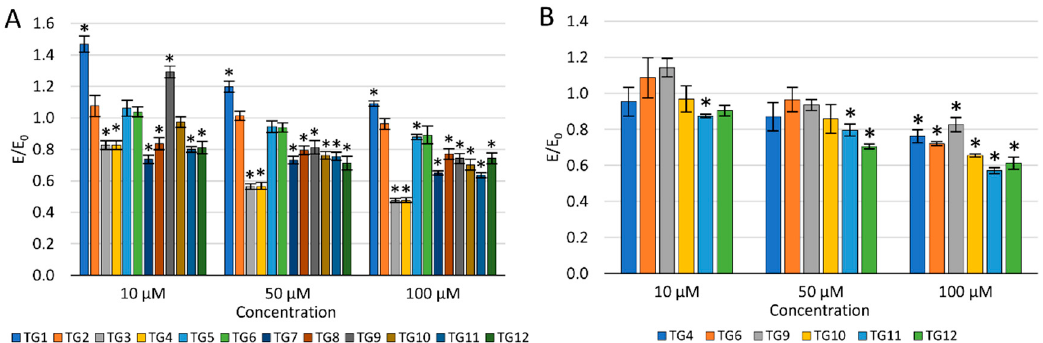
Figure 3. The effect of the tested compounds on the viability of normal human dermal fibroblasts (NHDF) cells ( A ) and human chondrocyte (TC28a2) cells ( B ); * p < 0.05—significant difference compared to the control.